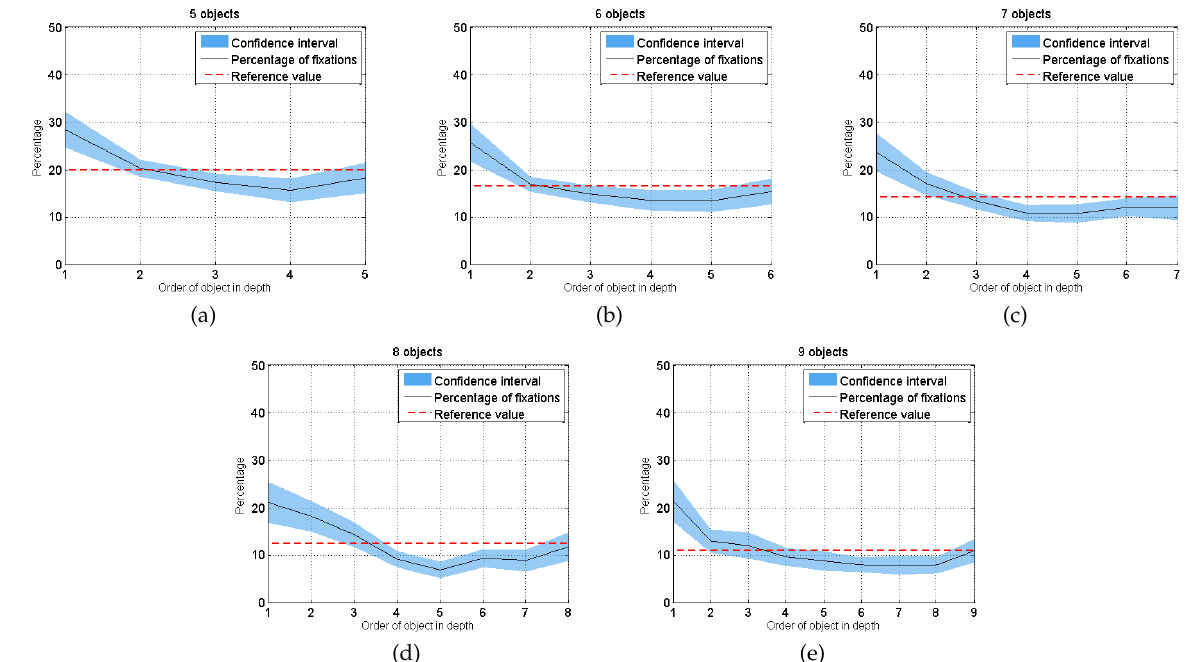
Figure 4 . Fixation distribution (all the fixations were considered for all the conditions) as a function of the order of object’s depth for the scenes containing different number of objects ( N ∈ 5 , 6 , 7 , 8 , 9 ). X axis is the order of objects; sub-figure (a) to (e) repesents the group of scenes that contain 5 to 9 objects, respectively. Y axis represents the percentage of number of fixations. The blue area represents the 95% confidence interval. The dash line represents the uniform probability distribution (1/N).